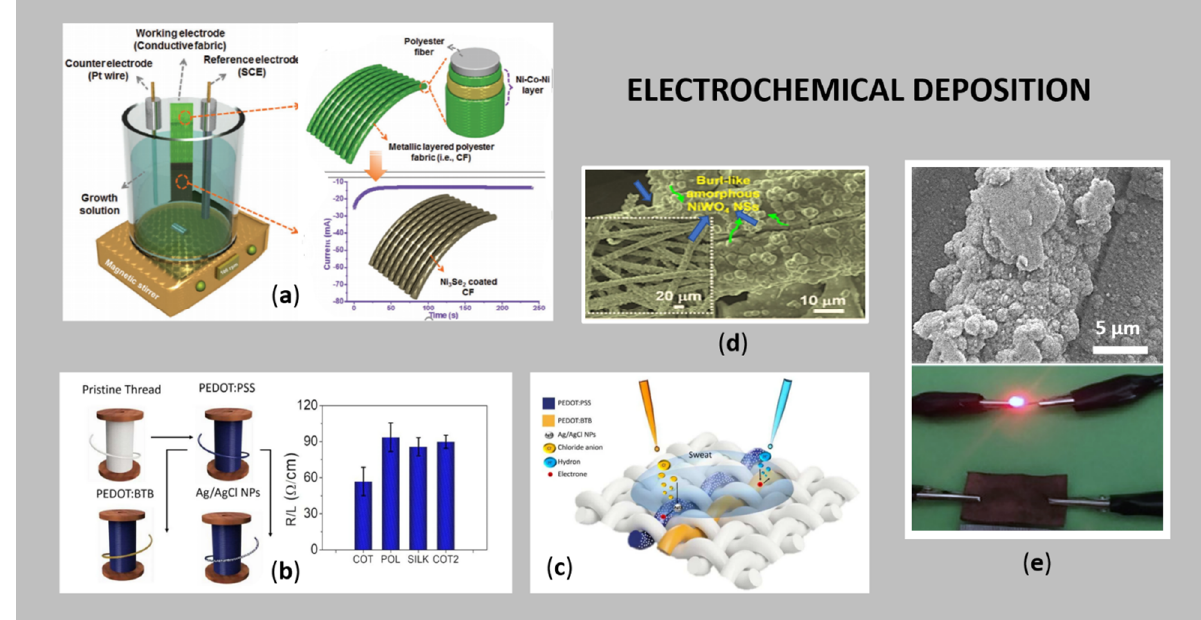
Figure 5. ( a ) Schematic electrodeposition process with a three-electrode system (reprinted with permission from Ref. [98] Copyright 2021, John Wiley and Sons); ( b ) average resistance values of differently electroplated conductive threads (reprinted with permission from Ref. [97] Copyright 2021, Springer Nature Limited); ( c ) working principle of the thread sensor that detects chloride ions, pH and sweat simultaneously (reprinted with permission from Ref. [97] Copyright 2021, Springer Nature Limited); ( d ) SEM image of PET coated uniformly with amorphous NiWO 4 (adapted from Ref. [89]); ( e ) SEM of Cu NP-coated PET knitted fabric and corresponding conductivity test (adapted from Ref. [99]).